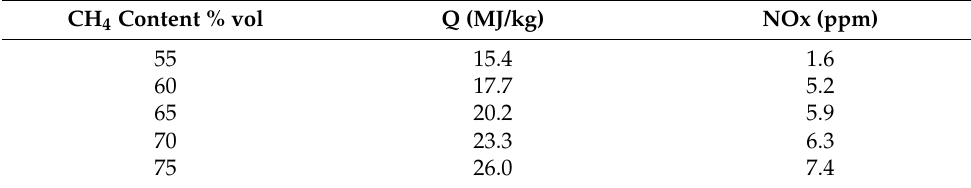
Table 8. Effect of methane content on NOx.